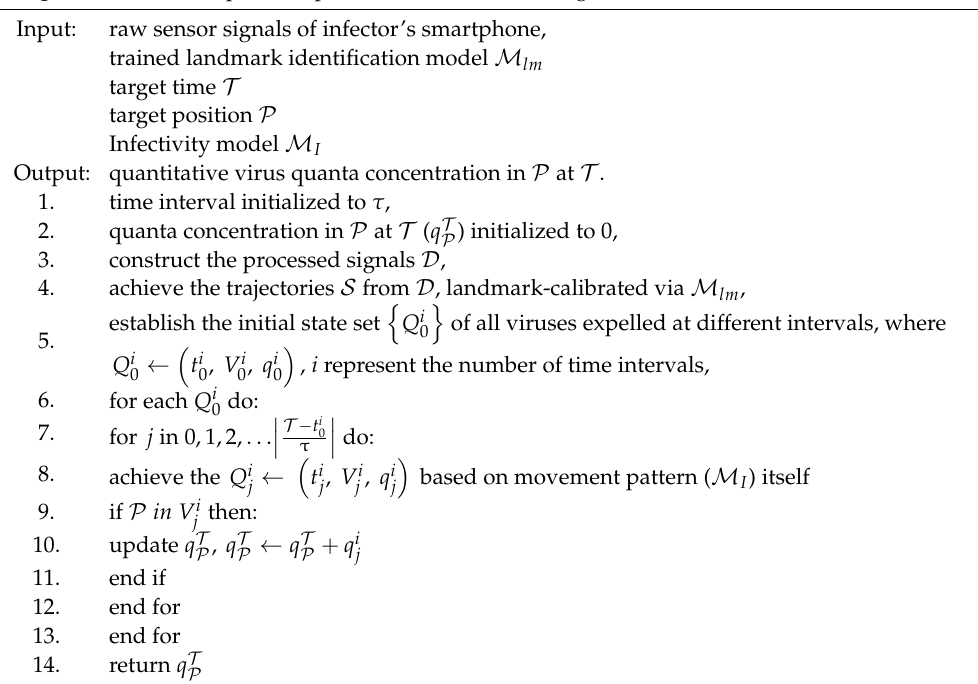
Algorithm 1 Indoor spatiotemporal contact awareness